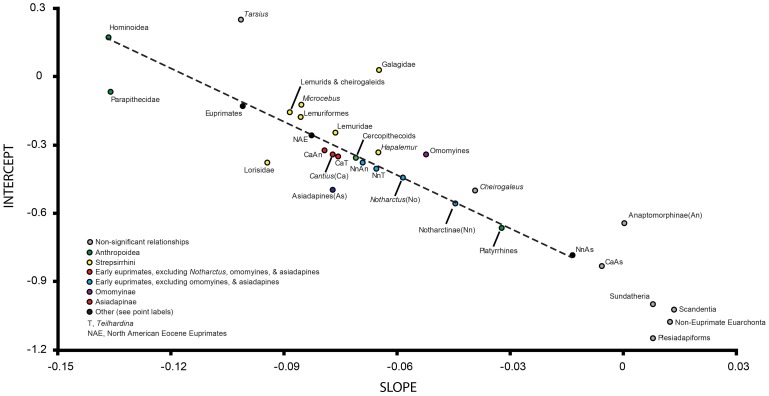
Comparison of ordinary least squares (OLS) lines by plotting slopes and intercepts.When using ordinary least squares, it is difficult to define a natural group to which to limit a sample for a scaling relationship. We dealt with this in several ways: 1) by starting with small (genus level) groups, and adding sister taxa until the slope and/or intercept of the line changed significantly, including the loss of a significant relationship. 2) For extinct taxa, we considered both phylogenetic proximity (not just monophyly). Our approach yielded a large number of regression equations (Table 2), which are difficult to compare with one another since changes in slope can be expected to yield changes in intercept. Therefore, we graphically compare the regression equation estimates by using slope of a relationship as the covariate and intercept as a dependent variable. This shows an expected relationship: more negative slopes have predictably higher intercepts. Fitting a line to this relationship we compare intercepts (or relative calcaneal elongation) as residuals from this line. This allows us to compare line position when methods like ANCOVA are not supported due to differing slopes of lines of interest. What can be seen is that parapithecids, asiadapines and lorisids have regression equations with the lowest residuals, Eocene taxa tend to have slightly negative residuals, lemuriforms have slightly positive residuals, omomyines have higher residuals, and galagos have the highest residuals. The tarsier relationship is non-significant (as is that for all gray points) so its position is not technically meaningful. However, the non-significant relationship for Tarsius appears mainly a result of small sample size (likely) given the high slope, in contrast to other non-significant relationships (“anaptomorphines,” scandentians, etc.) which have slopes close to zero. This plot presents data consistent with other ways of looking at body-size scaled levels of calcaneal elongation used in this study and suggests on average that early Eocene primates had lower levels of calcaneal elongation than extant lemuriforms.